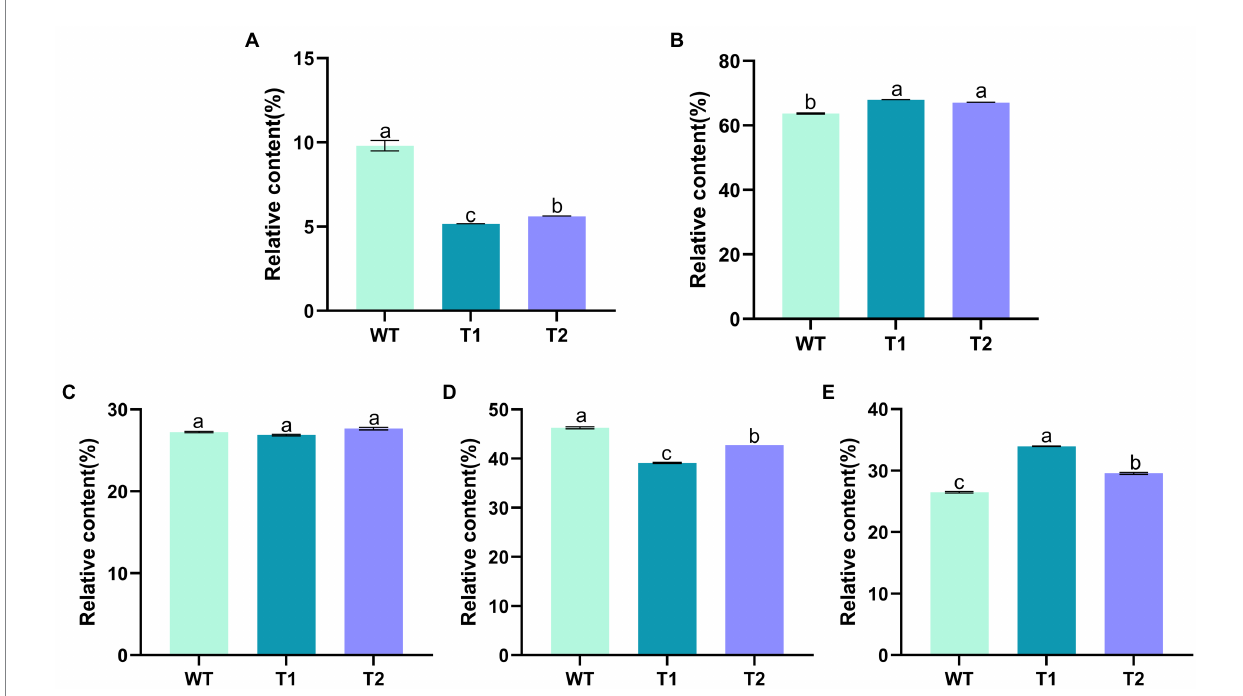
FIGURE 7 Relative content of fatty acids of different classifications. (A) Monounsaturated fatty acids. (B) Polyunsaturated fatty acids. (C) 16 C Fatty acids. (D) 18 C fatty acids. (E) 20 C fatty acids.